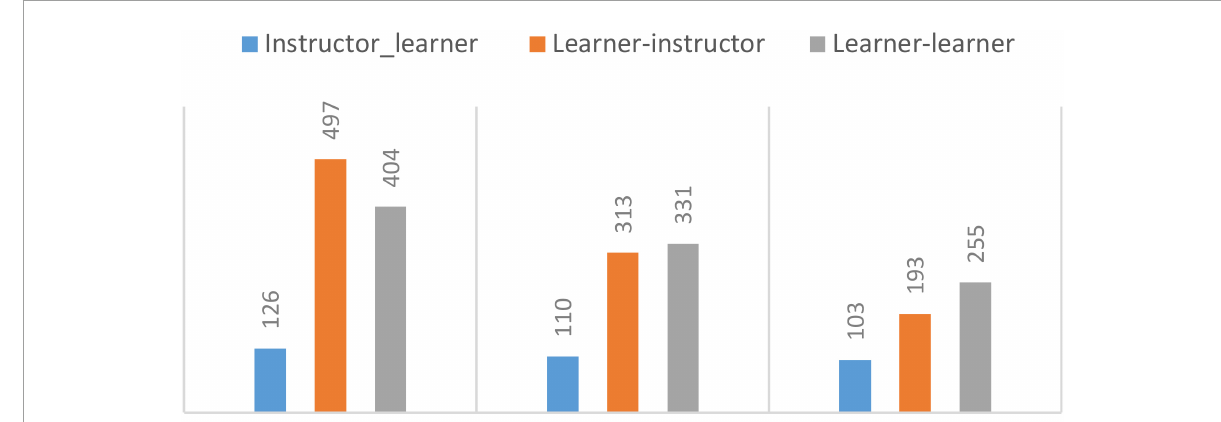
FIGURE1 Summary of statistics of data collected.